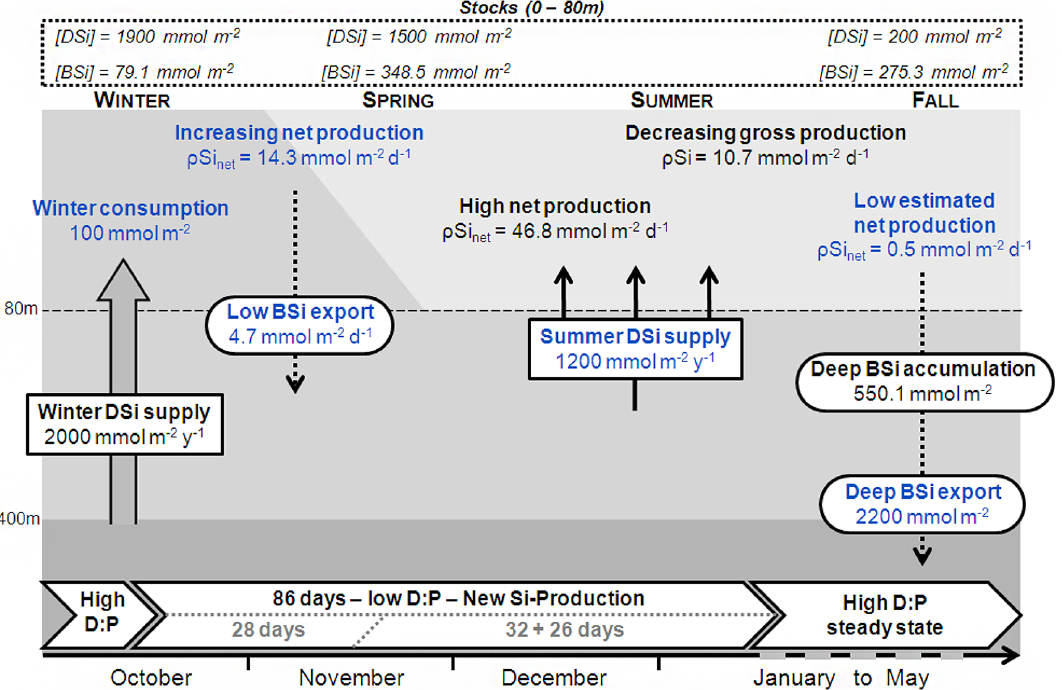
Figure 7. Schematic view of the seasonal silicon cycle in the mixed layer above the Kerguelen Plateau as estimated from natural and enriched Si isotopic measurements. Blue silicon fluxes correspond to estimated values while dark fluxes correspond to direct measurements. The three main water masses are represented in dark grey for Upper Circumpolar Deep Water (UCDW), medium grey for the winter water (WW) and light grey for the mixed layer (ML). Variation of biogenic silica and H 4 SiO 4 standing stocks integrated over 80m (respectively, [BSi] and [DSi]) are shown in the upper panel. Vertical continuous arrows represent DSi supplies from deep water to the ML, and dotted arrows correspond to particulate silica fluxes. Integrated silica production rates are calculated from the surface to 80m. Horizontal white arrows represent the state of the bloom (indicated by the D : P ratio) through time. Winter consumption has been estimated from the difference of winter mixing supply (Fripiat et al., 2011a) and the standing stock measured at the first A3 visit (KEOPS-2). The difference in standing stocks between the two visits at A3 (28 days, KEOPS-2) yields the net silica production of 14.3mmolm − 2 d − 1 . The DSi standing stock at the second visit of A3 would have been able to sustain the net silica production measured for 32 days (this study) while the summer DSi supply estimated by Fripiat et al. (2011a) would have been able to sustain the same net production by an extra 26 days. The fall production measurements and standing stocks are from Mosseri et al. (2008, KEOPS-1). Since no silica dissolution is available from KEOPS-1, fall net production has been estimated from the difference between average gross silica production during KEOPS-1 (Mosseri et al., 2008) and average silica dissolution measured at all stations south of the polar front (KEOPS-2, this study). Deep BSi accumulation is calculated by integrating data from Mosseri et al. (2008) over the 100–200m depth layer (see text for further